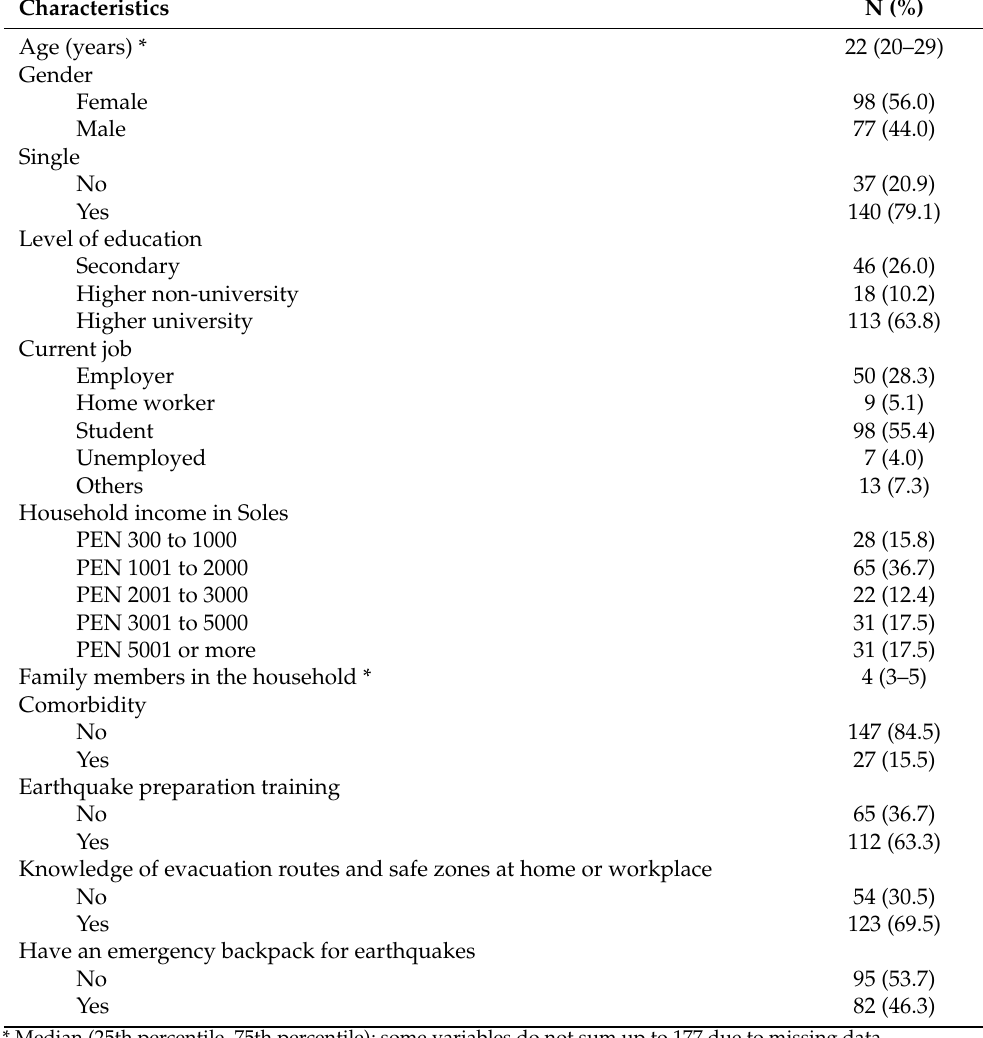
Table 1. Characteristics of participants (n =